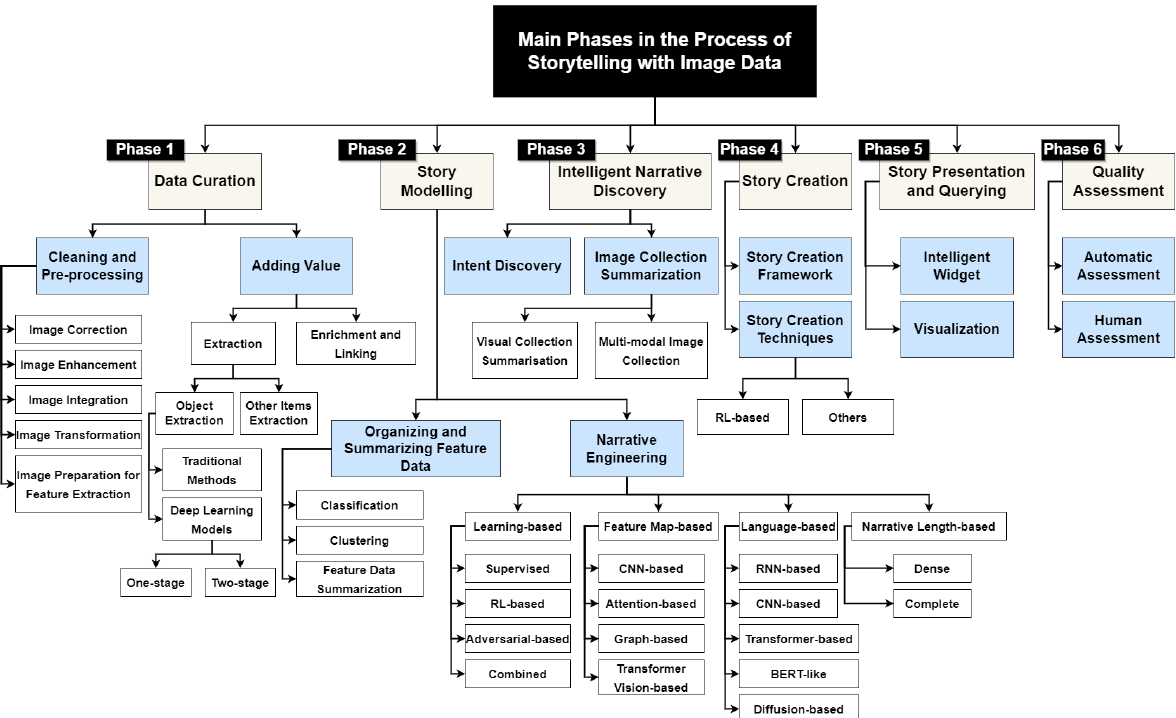
Figure 2. The proposed taxonomy for storytelling with image